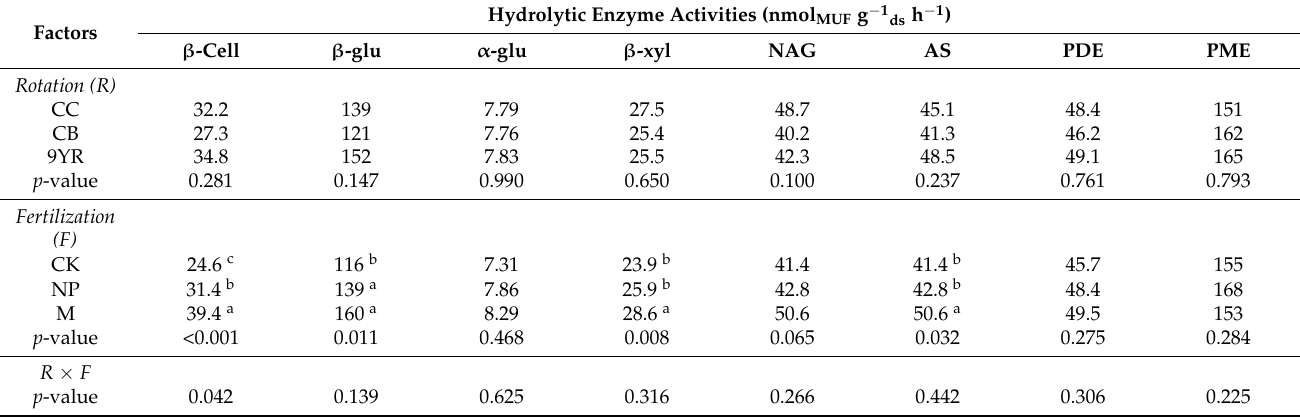
Table 2. Marginal means of soil β -cellobiosidase ( β -cell), β -glucosidase ( β -glu), α -glucosidase ( α -glu), β -xylosidase ( β - xyl), N-acetyl- β -glucosaminidase (NAG), arylsulfatase (AS), phosphodiesterase (PDE), and phosphomonoesterase (PME) activities for rotation and fertilization effects. Different upper-case and lower-case letters indicate significant differences ( p -value < 0.05), respectively, between rotation and between fertilization as determined by the Fisher’s LSD test.